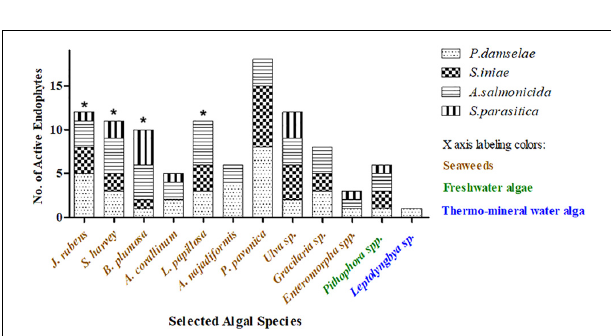
FIGURE 5 | Distribution of the isolated endophytes by algal genus and their activity against aquaculture pathogens. Endophytes were isolated from the indicated algae and tested for their bioactivity against one oomycete and three bacterial pathogens. Endophyte activity is demonstrated as the sum of all inhibition events by the isolated endophytes of a certain alga. Each pathogen is marked by a different pattern in the bars. * The number of active endophytes from a particular alga can be greater than the sum of isolates from that same alga because the same isolate can be active against more than one pathogen.